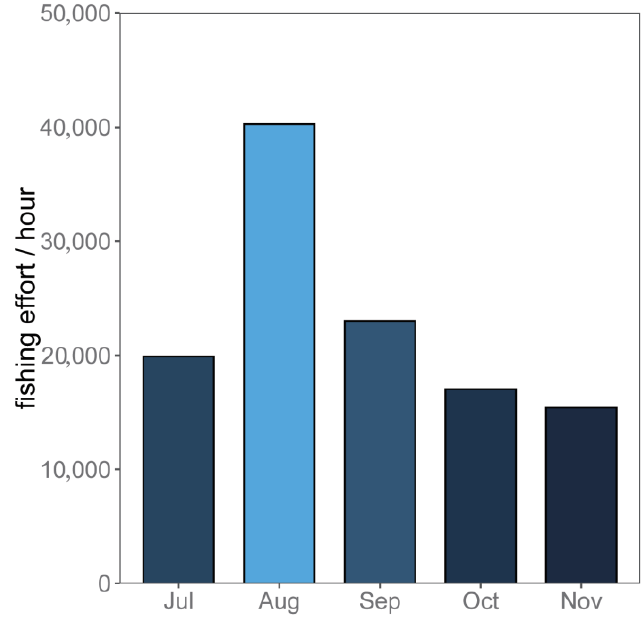
Figure 3. Average monthly fishing effort of squid-jigging vessels in the North Pacific Ocean from July to November during 2017 to